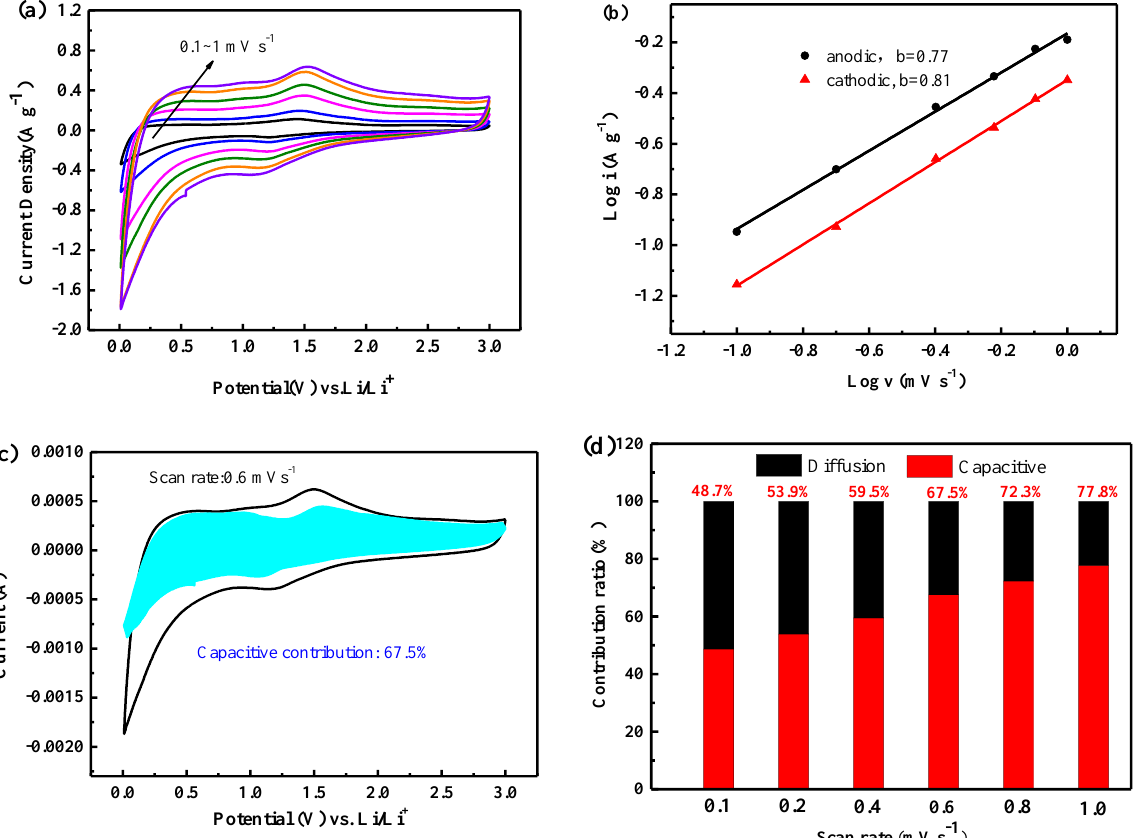
Figure 9. Kinetics analysis of the electrochemical performance toward Li + for the MON-QD/NG-600 electrode: ( a ) CV curves at scan rates from 0.1 to 1.0 mV s − 1 ; ( b ) the corresponding relationship between the scan rate and peak current; ( c ) CV curves and capacitive contribution to the total charge storage of MON-QD/NG-600 electrode at 0.6 mVs − 1 ; ( d ) contribution ratios of the capacitive and diffusion-controlled capacities at different scan rates.